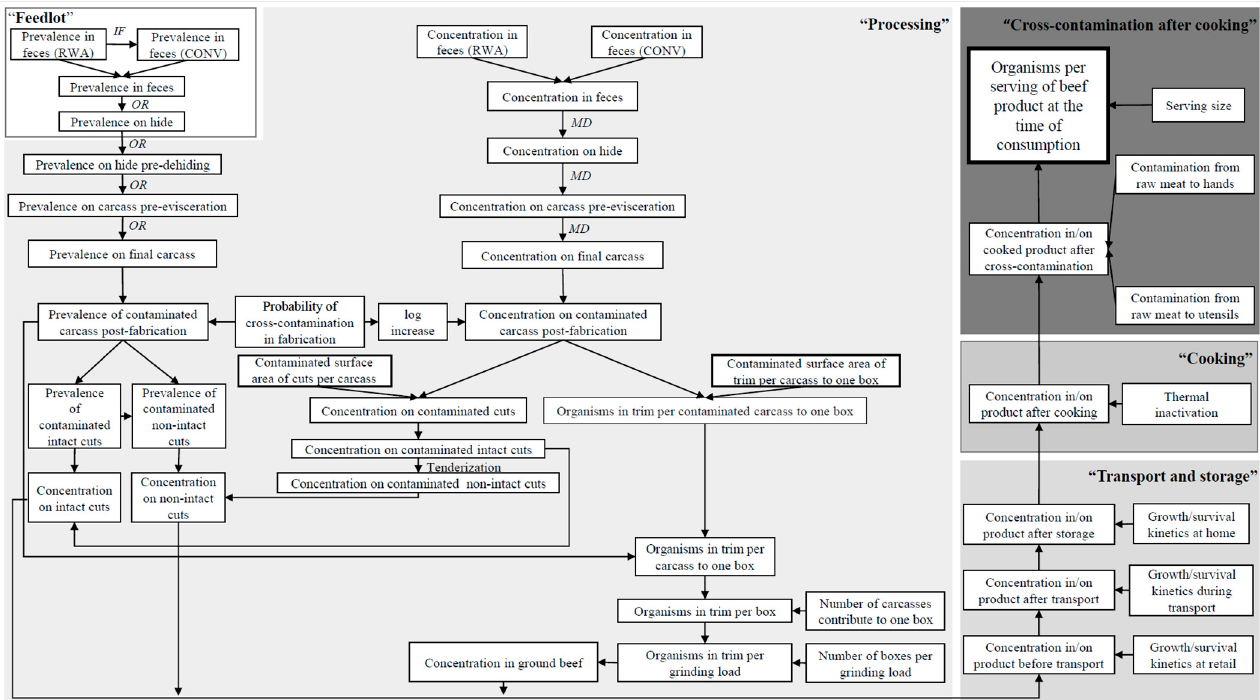
Figure 1. Schematic diagram of the quantitative microbial exposure assessment model. RWA—raised without antibiotics; CONV—conventional; IF —impact factor; OR —odds ratio; MD —mean difference.